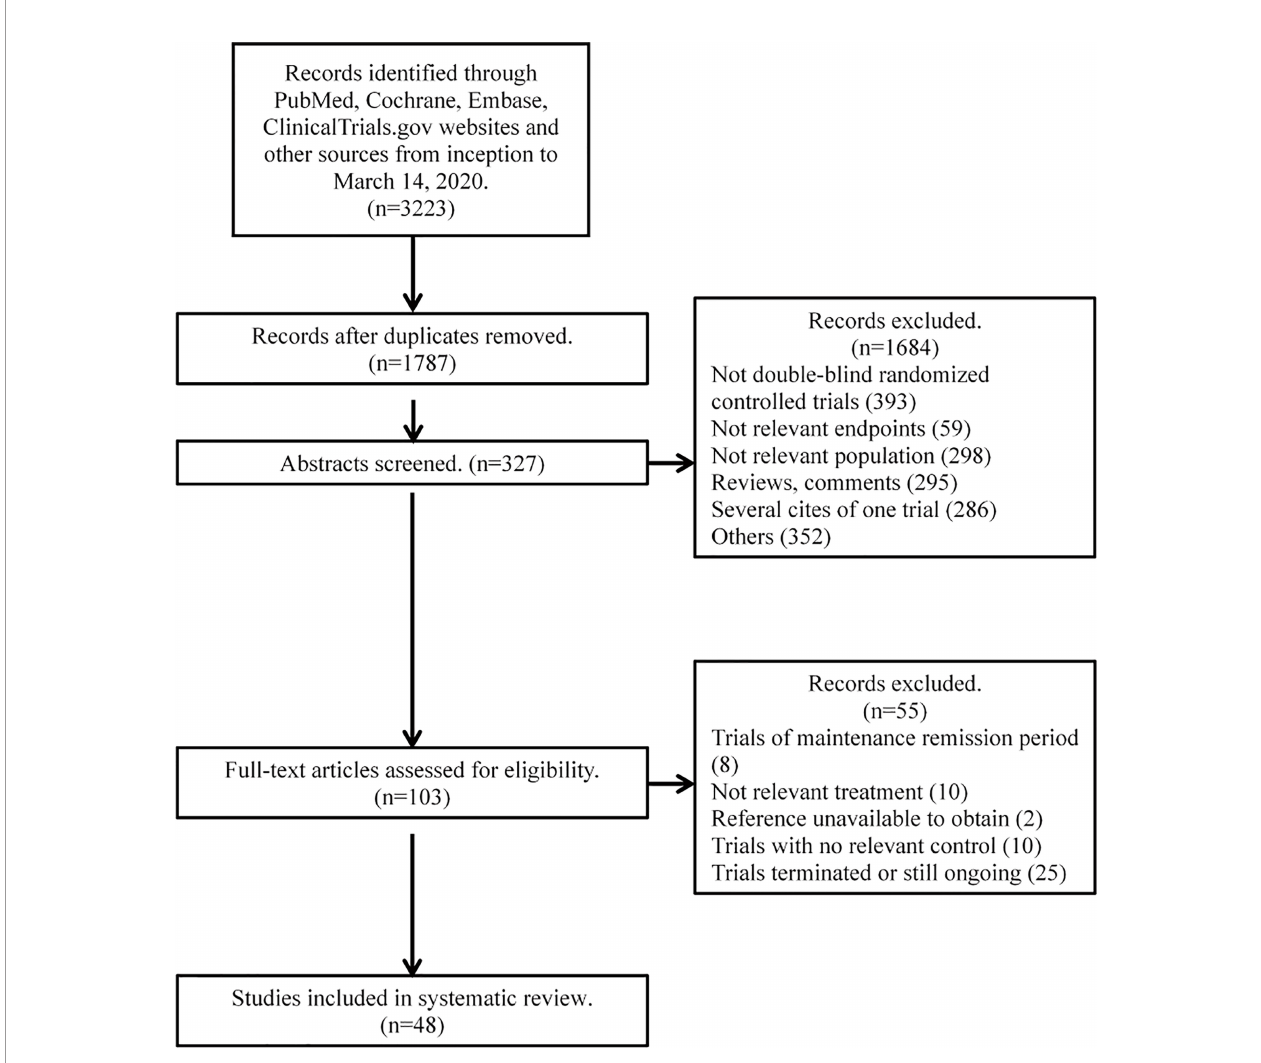
FIGURE 1 | Flow diagram for study